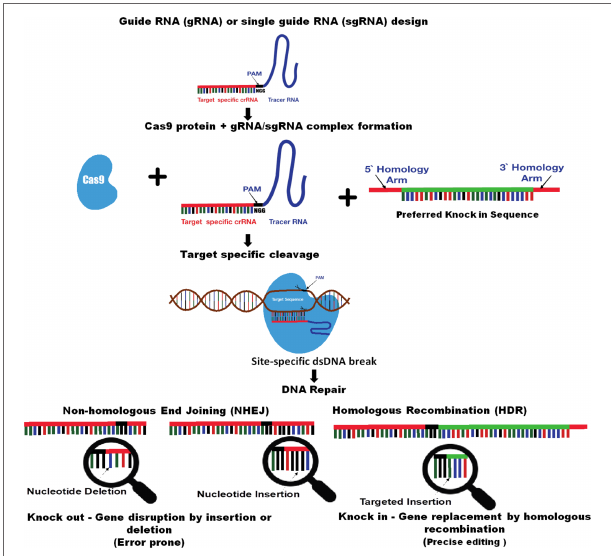
FIGURE 1 | Schematic diagram of CRIPSR/Cas–mediated genome editing technology (adapted from Mohapatra and Chakraborty, 2021). Guide RNA (gRNA) or single-guided RNA (sgRNA) consists of a CRISPR RNA (crRNA) sequence that is specific to the targeted DNA and a transactivating crRNA (tracrRNA) sequence that interacts with the Cas9 protein. The target sequence contained within the gRNA or sgRNA has a species-specific short protospacer adjacent motif (PAM) sequence (–NGG). gRNA/ sgRNA guides the Cas9 endonuclease to the targeted genomic locus; then, the CRISPR/ Cas9 complex binds and cleaves it. Cas9-mediated site-specific DNA cleavage is directed by complementary between the gRNA/ sgRNA and the target sequence upon the presence of a PAM sequence on the opposite strand. The enzymatic activity of Cas9 cleaves both strands of genomic DNA, resulting in a double-strand break (DSB). A CRISPR-Cas induced DSB is repaired by either non-homologous end-joining (NHEJ) or homologous recombination (HDR). NHEJ is more efficient than HDR but is error prone and may induce unpredictable indels, whereas HDR can provide a precise gene